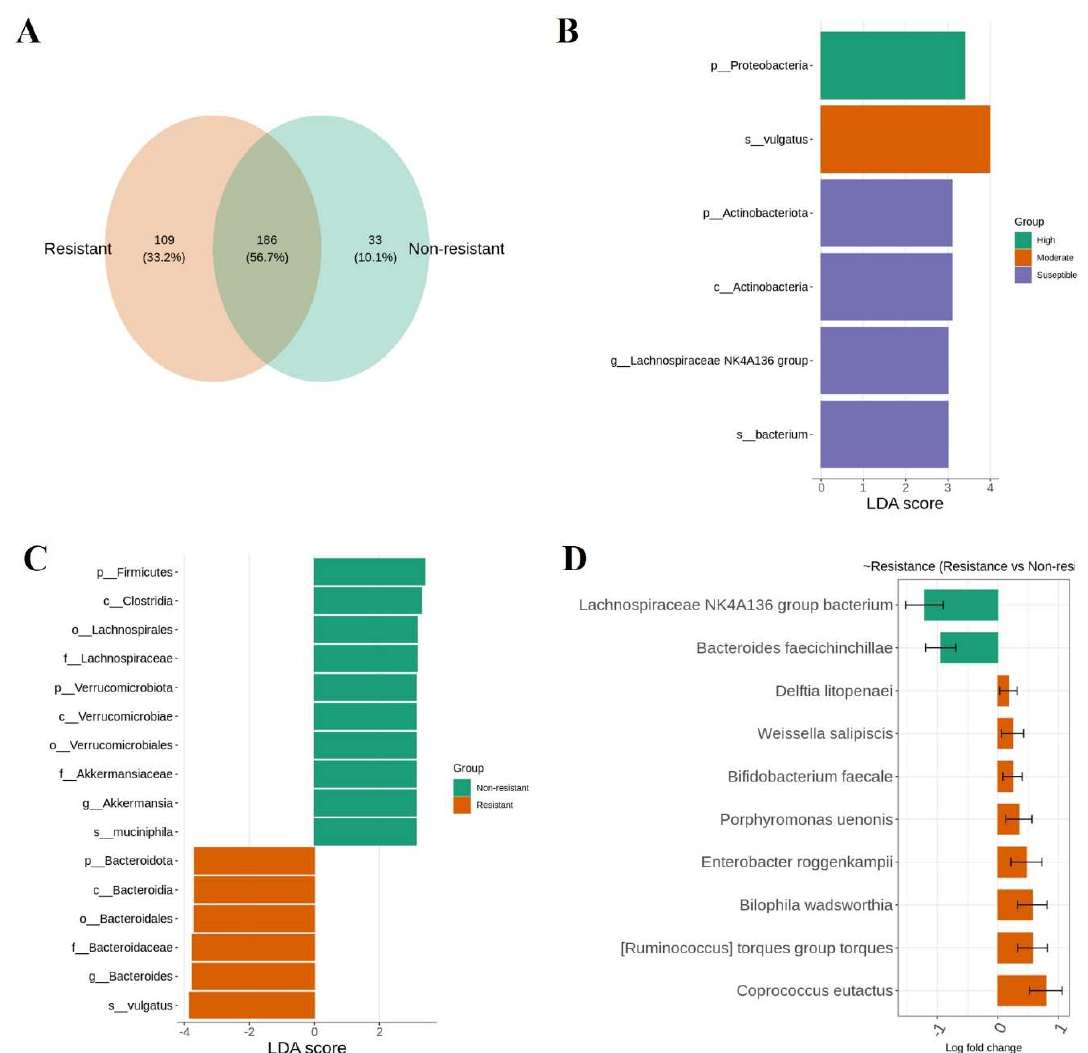
Figure 6. Bacterial community composition of Colombian Ae. aegypti midguts associated with lambda–cyhalothrin susceptibility, and moderate and high resistance. ( A ) Venn diagram of bacteria showing the common and unique OTUs in insecticide-resistant and non-resistant females. ( B , C ) An abundance of bacterial taxa among groups using LEfSe analysis. LDA scores of biomarker bacteria are shown as horizontal bars for biomarker bacteria with an LDA score (log10) > three and with an alpha value of 0.05. ( D ) Differential abundance analysis stratified by resistance using ANCOM-BC (significant at 5%).